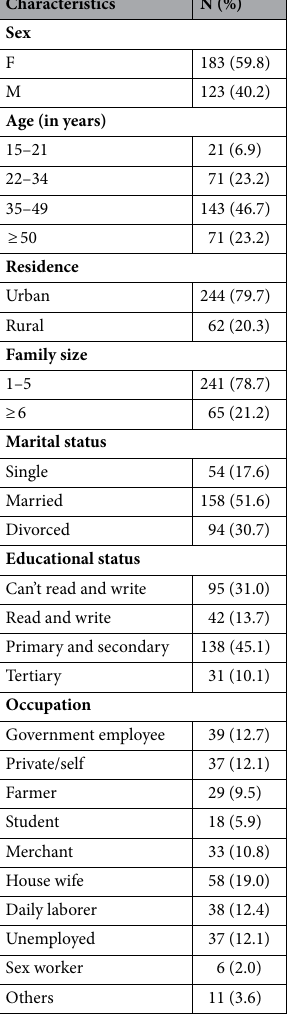
Table 1. Socio-demographic characteristics of IAHBc individuals in public Hospitals, Eastern Ethiopia, 2017/18 (n =